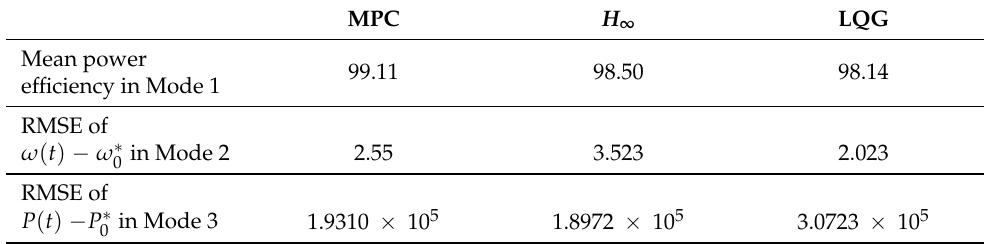
Figure 16. Open–loop frequency responses of PID, MPC, LQG, and H ∞ controllers based on Bladed linearized model in mode 3. Table 2. Controllers performance in each